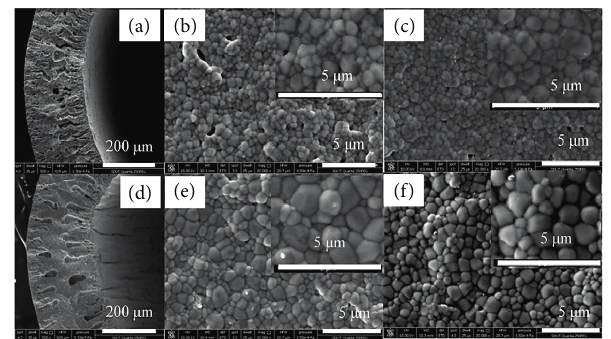
Figure 7: Image segmentation technique.